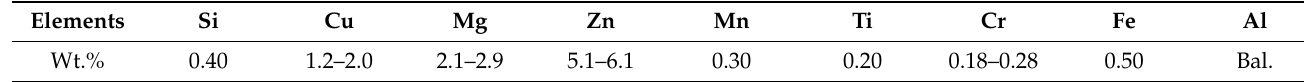
Figure 1. SEM of the W particles. Table 1. Chemical composition of the 7075 Al alloy (wt.%).